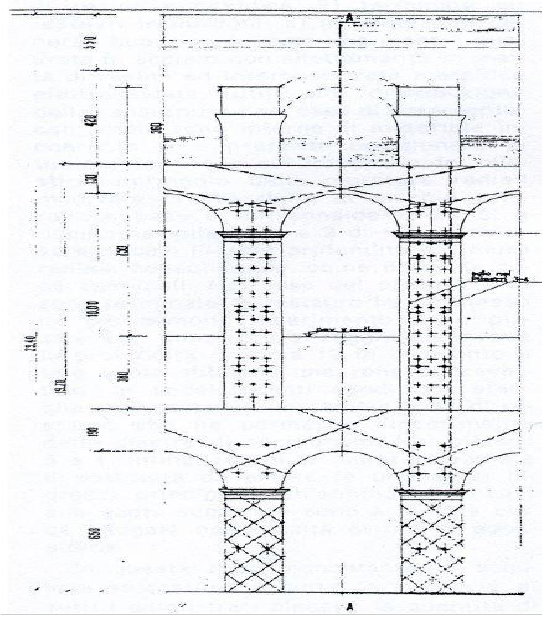
Figure 10. Drawings of the retrofit intervention project, with post – tension cables designed at the second level of the right column.